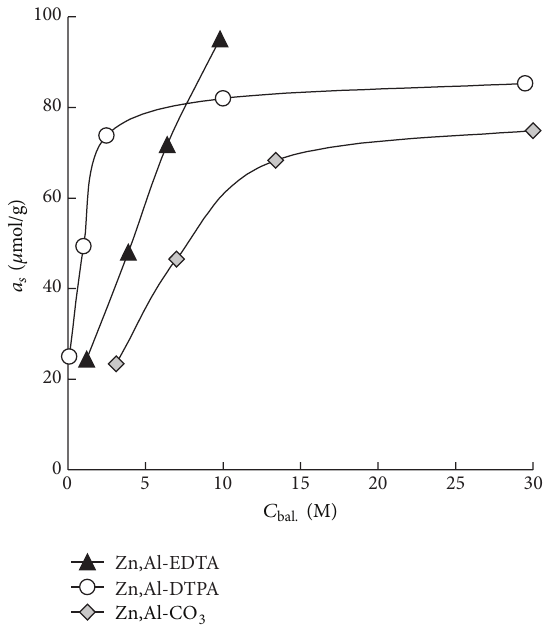
Figure 7: Comparative evaluation of the recovery efficiency of = 50 cm 3 , and 𝑚 = 0.100 g. U(VI) compounds from aqueous media with different adsorbents, solution adsorbent = 50 cm 3 pH 8. 𝑉 sol .